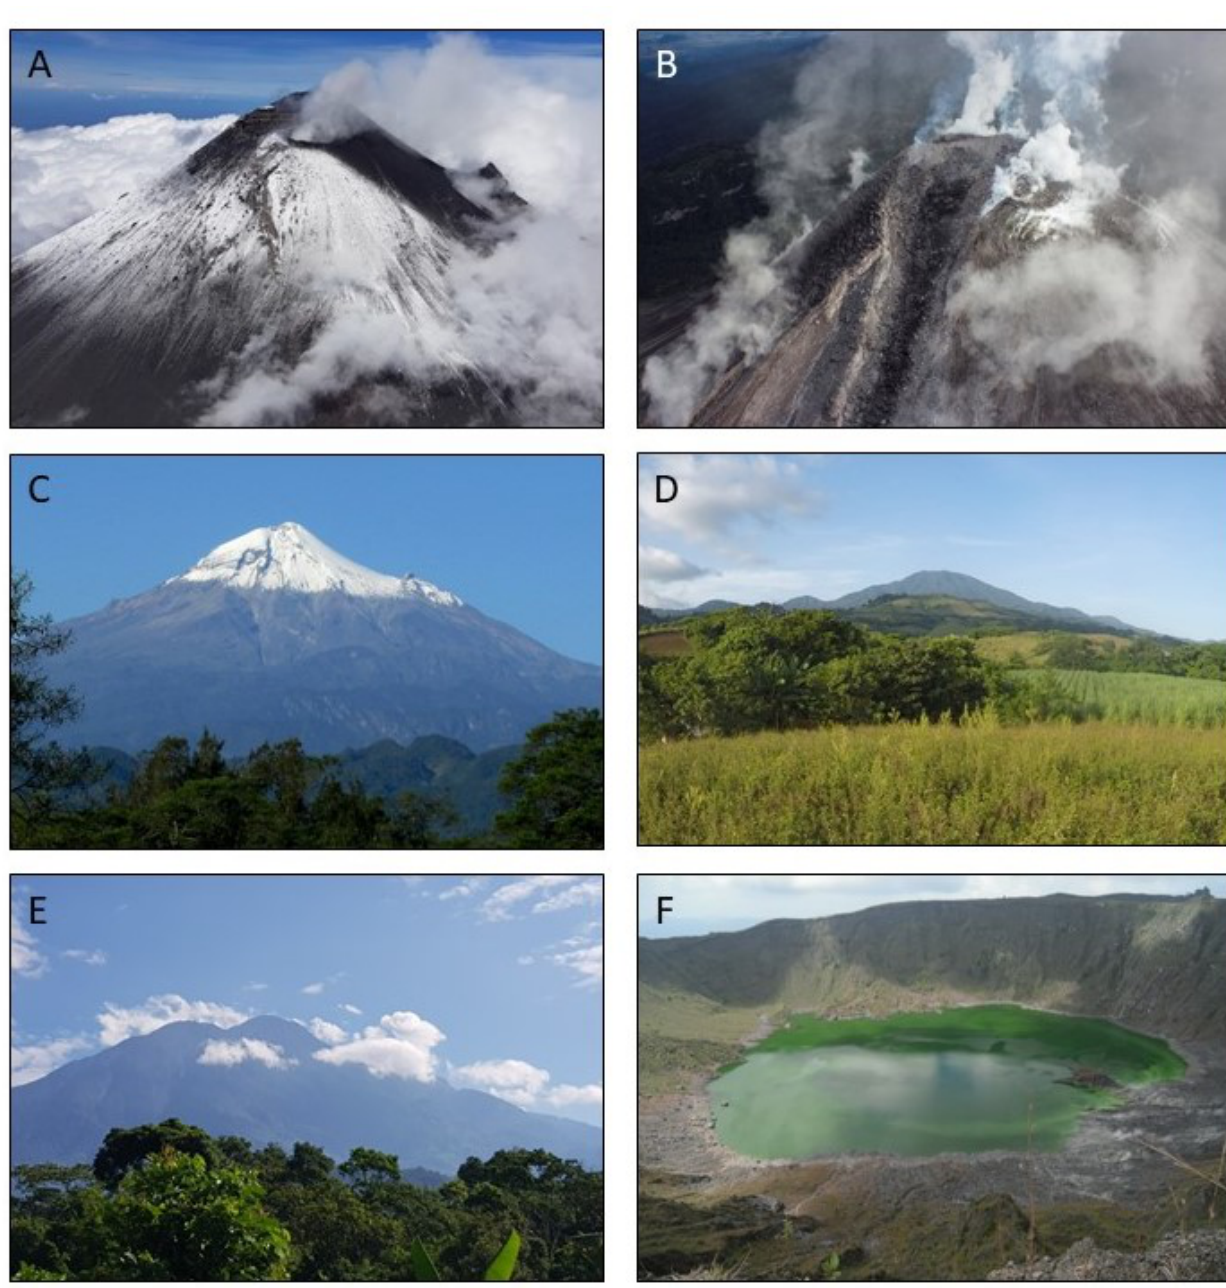
Figure 2: Main volcanoes monitored in México. [A] Popocatépetl viewed from the East, showing ashes and ballistic deposits over recent snow (photo credit: Ramón Espinasa-Pereña, July 2019). [B] Colima, showing one of the 2015 lava flows issuing from the crater (photo credit: Raúl Arámbula, July 2015). [C] Citlaltépetl (Pico de Orizaba) towering over the coastal plain (photo credit: Katrin Sieron, October 2018). [D] San Martin Tuxtla and several of the parasitic cones that form the Tuxtlas volcanic field (photo credit : Katrin Sieron, April 2010). [E] Tacaná volcano high above the Tapachula plains at the Guatemala border (photo credit: Ramón Espinasa-Pereña, August 2018). [F] Crater of El Chichón volcano left after the 1982 eruption, with a lake of sulfurous water (photo credit: Miguel Alatorre, October